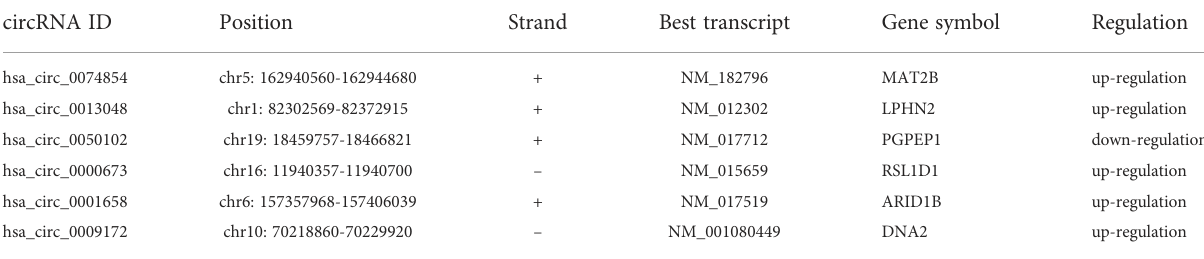
TABLE 1 Details of circRNAs.